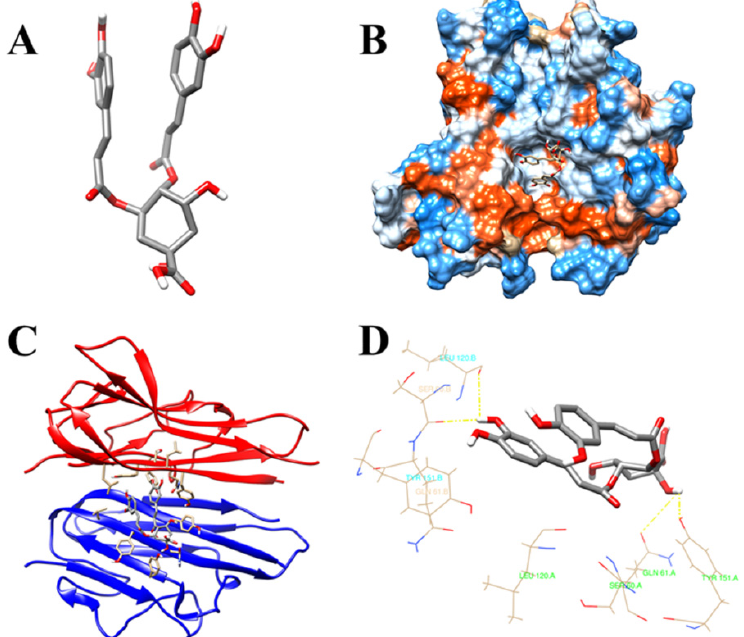
Figure 6. Binding mode of isochlorogenic acid B with TNF. The 3D structure of isochlorogenic acid B ( A ) and the 3D crystal structure of human TNF ( B ). Isochlorogenic acid B stably dock with the endogenous ligand binding site in TNF ( C ) and the potential interactions between isochlorogenic acid B with TNF ( D ).